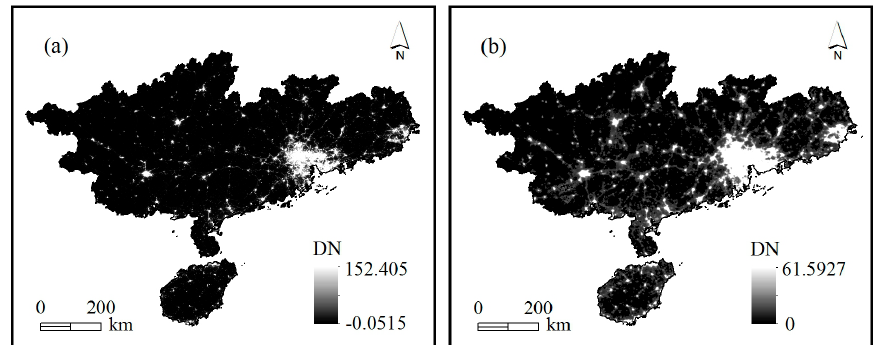
Figure 2. Spatial distribution of nighttime light data across South China: ( a ) the composite National Polar-Orbiting Partnership-Visible Infrared Imaging Radiometer Suite (NPP-VIIRS) nighttime light brightness in 2014; and ( b ) the corrected Defense Meteorological Satellite Program-Operational Linescan System (DMSP-OLS) nighttime light brightness in 2012.